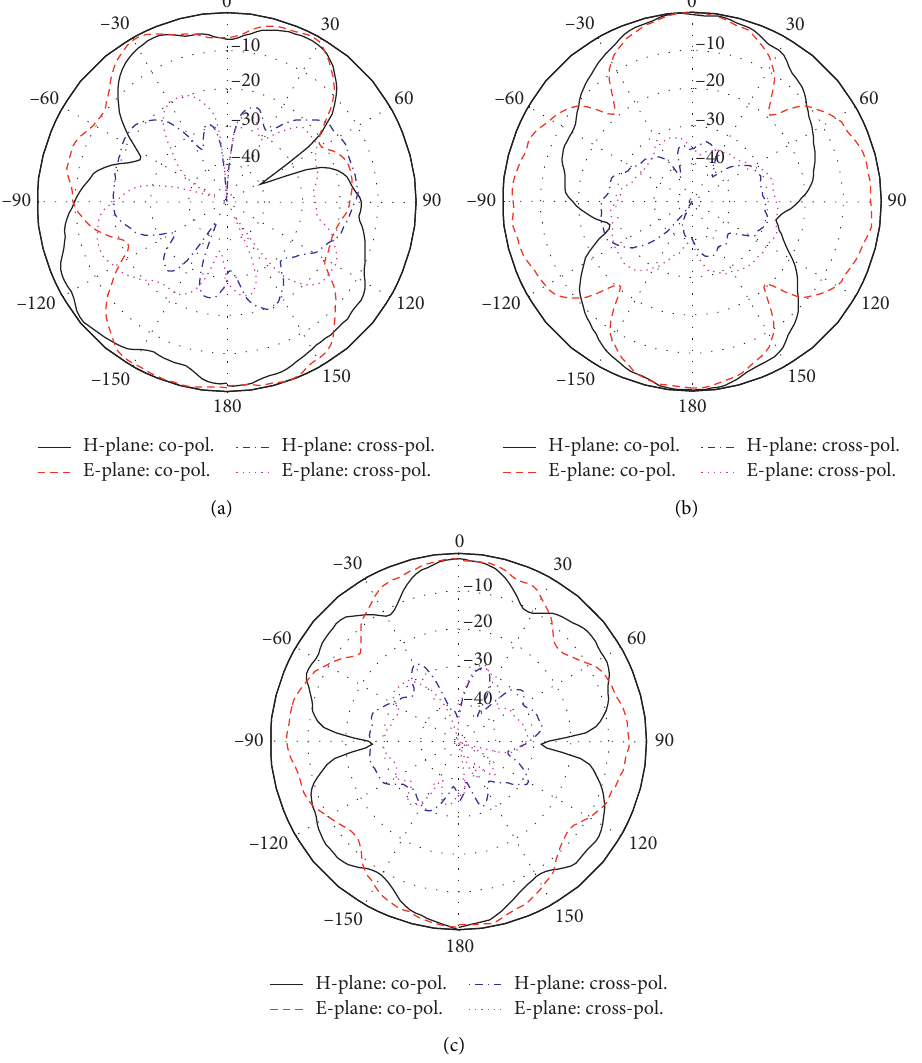
Figure 8: Radiation patterns of the proposed antenna array in the H- and E-planes at (a) 0.95, (b) 1.85, and (c) 2.45GHz.